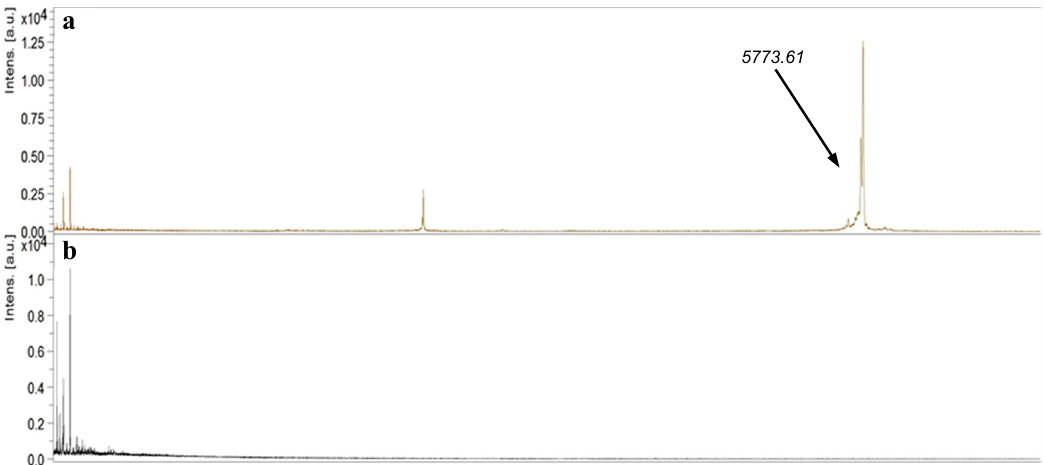
Figure 9. Mass spectrum of commercial insulin ( a ) and of the hydrolysate for empty capsules ( b ) .